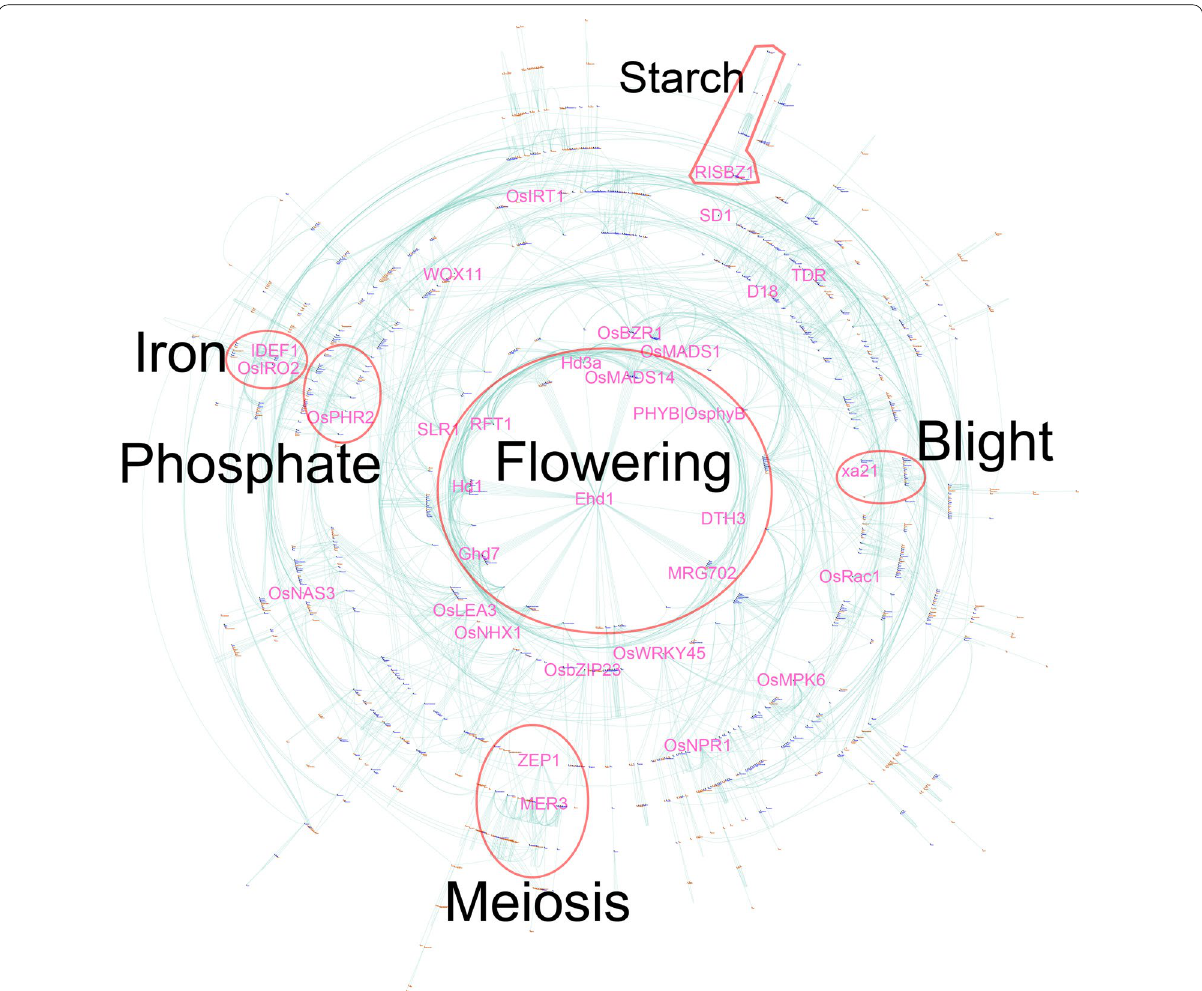
Fig. 4 A comprehensive interaction network comprising 1281 rice genes. Each functionally characterized rice gene is represented as a node with the corresponding gene symbol marked beside. Interacting gene pairs are connected by green lines. Representative well-known genes are indicated with larger font sizes. A total of 762 genes in the largest interaction network built in the previous study are indicated in blue, while 519 new genes involved in the largest network built in the present study are in saddle brown. Genes involved in the same biological pathways are highlighted by red ellipses or